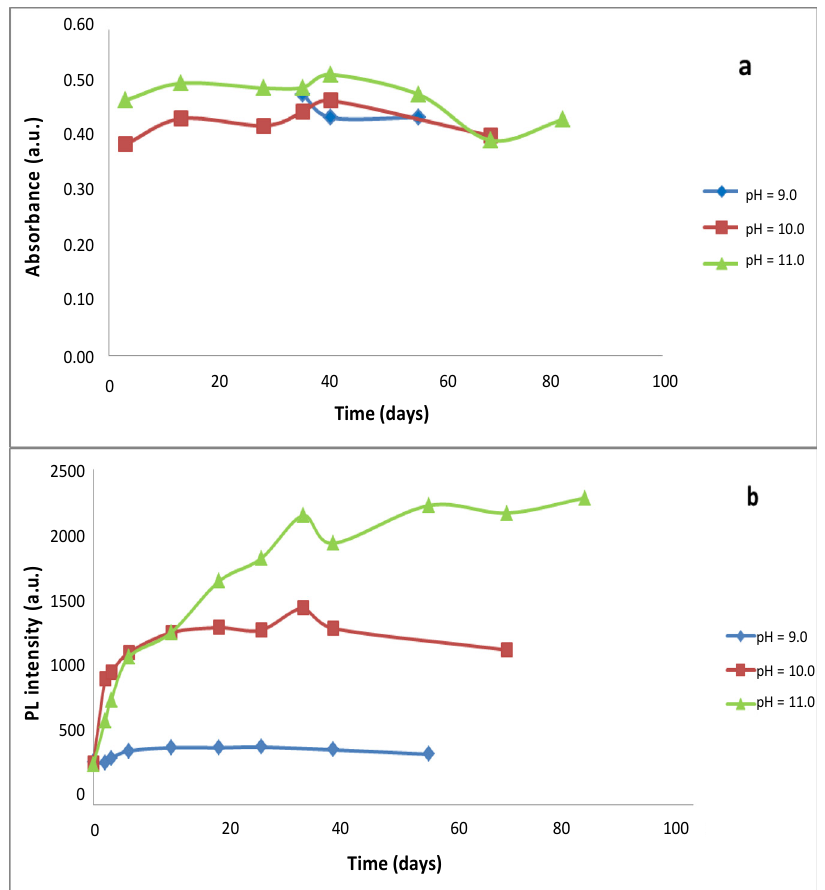
Figure 4. Influence of the change in pH values during synthesis at low temperatures. ( a ) Evolution of the absorbance values of the nanoparticles at different times for different pH values. ( b ) Temporal evolution of the Photoluminescence intensity at different pH values. Under operating conditions the final concentration and their molar ratios were as follows: [Cd 2+ ] F = 7.477 × 10 − 4 mol/L; [BSA] F = 3.738 × 10 − 4 mol/L; [thioacetamide] F = 3.738 × 10 − 4 mol/L; [Cd 2+ ] F /[thioacetamide] F = 2.0; [Cd 2+ ] F /[BSA] F = 2.0, 4 °C.